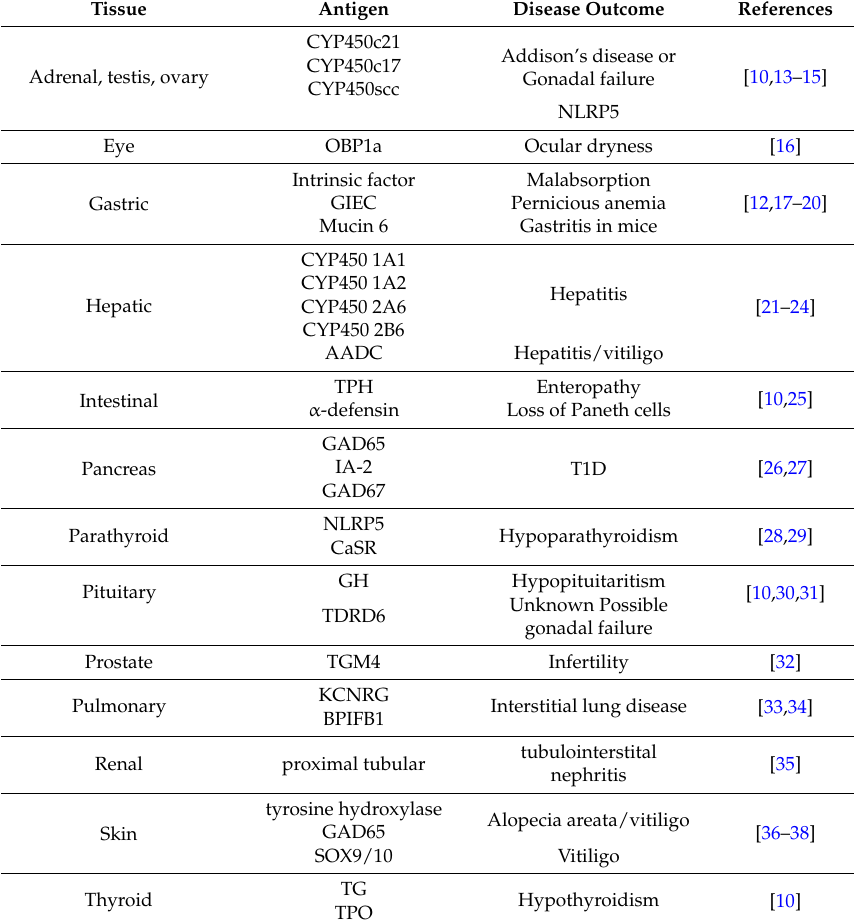
Tissue-specific autoantibodies identified in patients with APECED (Autoimmune polyendocrinopathy-candidiasis-ectodermal